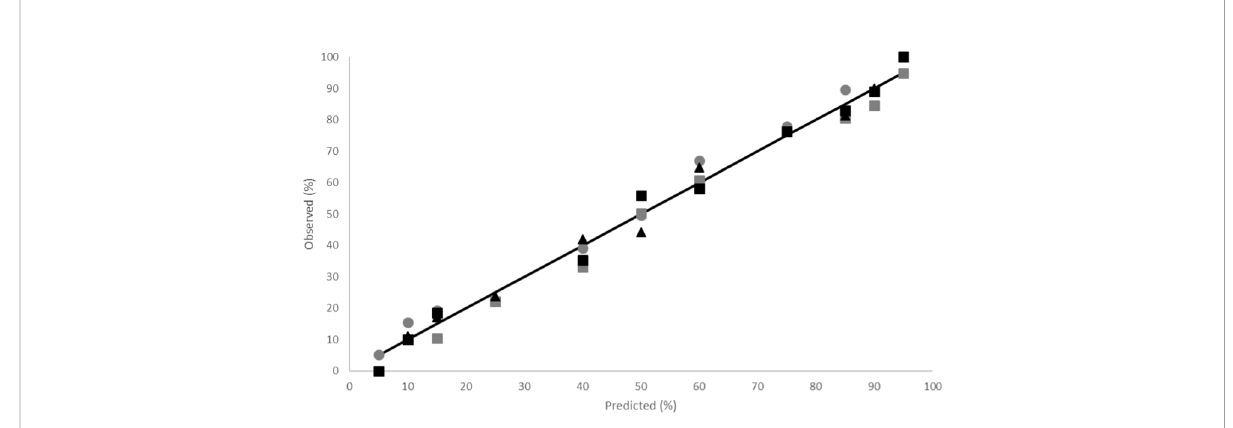
FIGURE 2 Summary of the observed versus predicted percentages of each haplotype extracted from the IS172:IS132 (grey symbols) and IS162:IS132 (black symbols) mock communities, with circles, squares and triangles representing isolates IS172, IS132 and IS162, respectively. The solid line represents perfect agreement between predicted and observed percentages of haplotypes.